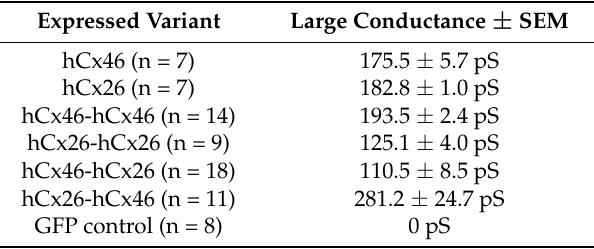
Table 3. Large conductance states of the gap junction channels expressed in transfected N2A cell pairs. n gives the number of analyzed cell pairs for each